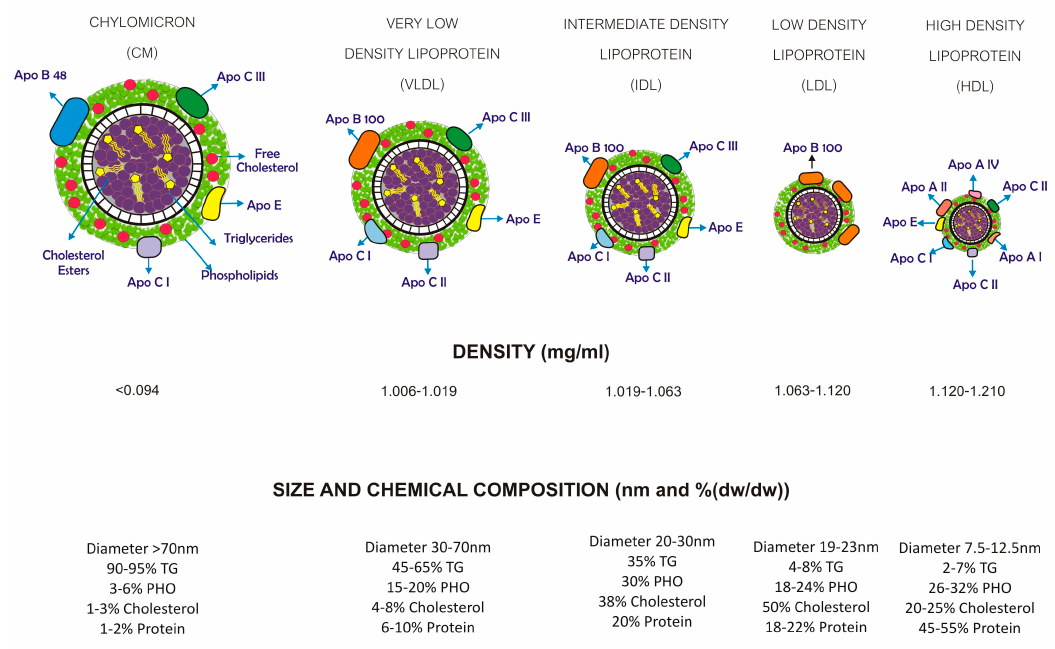
Figure 1. Classes and composition of lipoproteins. The classification criterion is based on the flotation density of the lipoproteins, the proportion of the different lipids and apolipoproteins, and the diameter of the particle. Chylomicrons (CM) are large, triglyceride-rich, and made in the enterocytes. The removal of triglycerides from very low-density lipoproteins (VLDL) results in the formation of intermediate-density lipoprotein (IDL) particles which are enriched in cholesterol and triglycerides and are pro-atherogenic. Low-density lipoproteins (LDL) are enriched only in cholesterol and are the most pro-atherogenic particles. High-density lipoproteins (HDL) are smaller than the other lipoproteins and enriched mainly in proteins. TG = triglycerides; PHO = phospholipids; Apo = apolipoprotein.